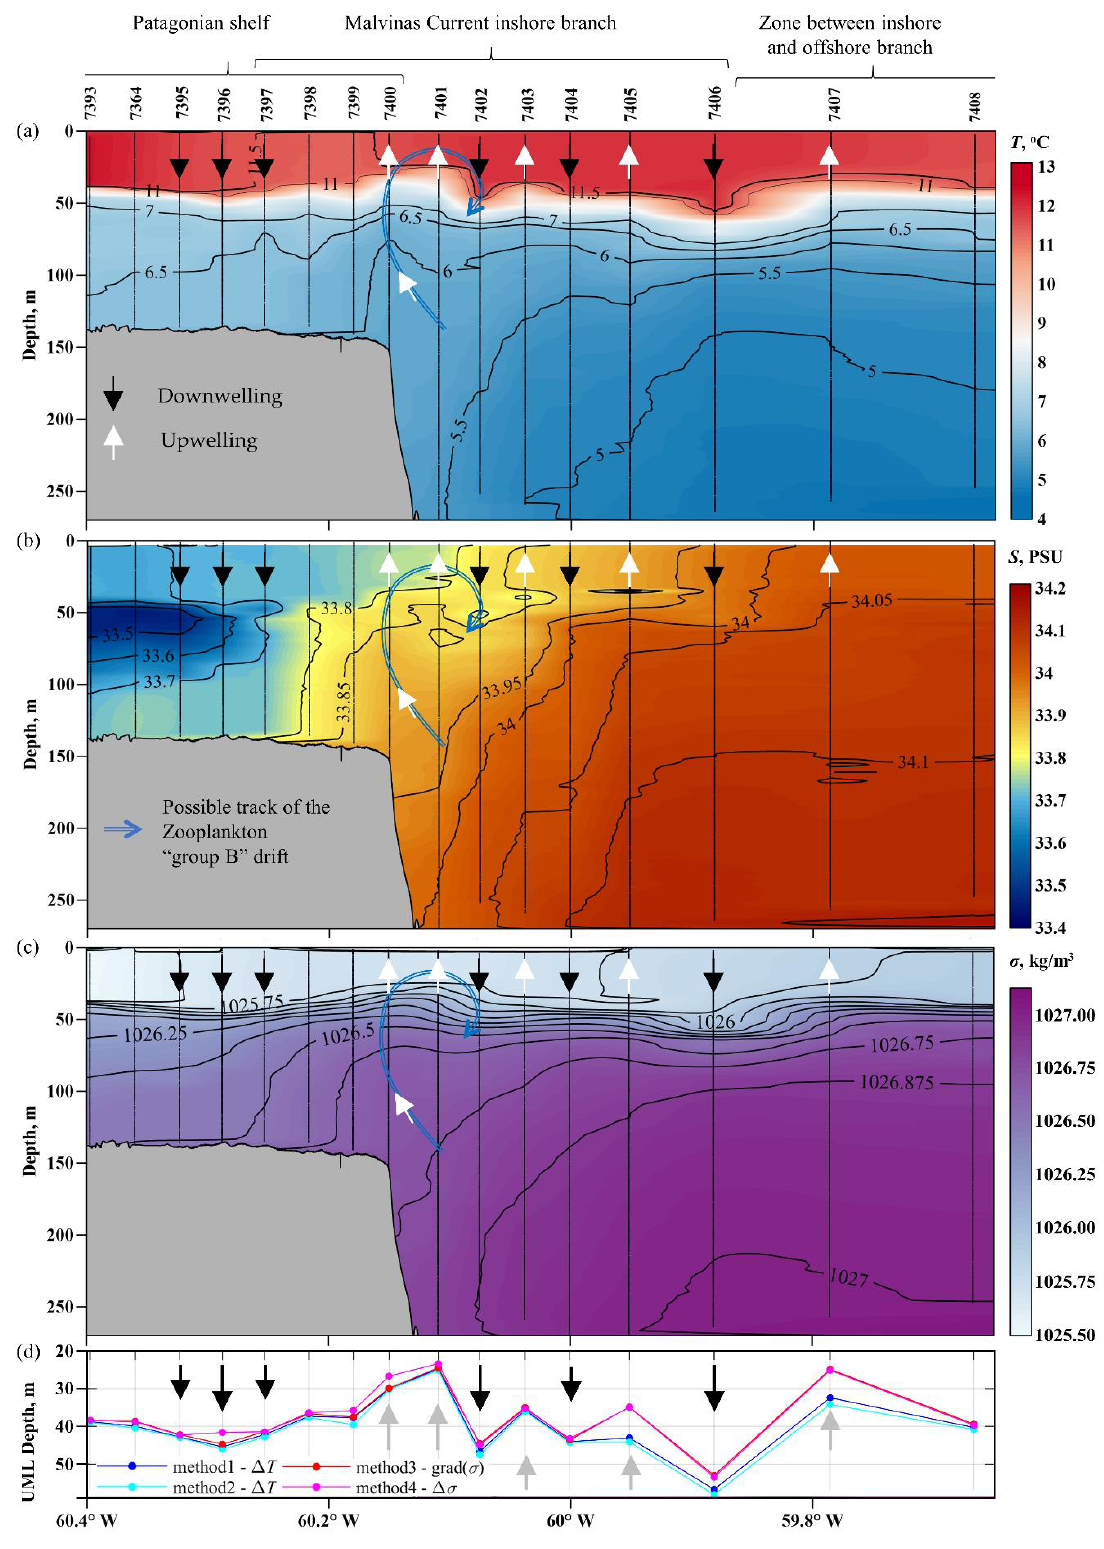
Figure 4. Zonal sections of: temperature, °C ( a ); salinity, PSU ( b ); density, kg/m3 ( c ); and spatial variations of upper mixed layer depth (UML), estimated by method 1 [33], 2 [34], 3 [35] or 4 [36] ( d ). At stations 7400 – 7401, upwelling manifested itself most clearly in the UML as the ascent of the lower boundary of the mixed layer. Above the shelf break at a depth of about 80 m, this process is reflected by the elevation of the 6 °C isotherm at station 7400. An